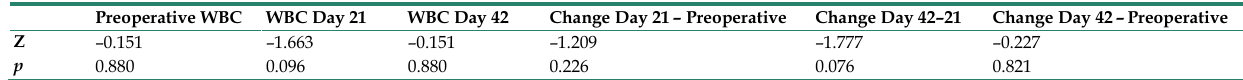
Table 4 : Statistical comparisons of WBC counts by time and between the two